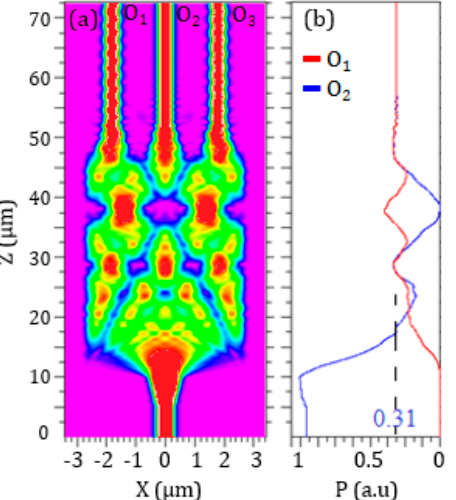
Figure 10. 3D BPM simulations of the 1 × 3 MMI in SOI technology. ( a ) Light propagation and ( b ) power distribution in the MMI and at the output waveguides. O 1 is the power in the optical path